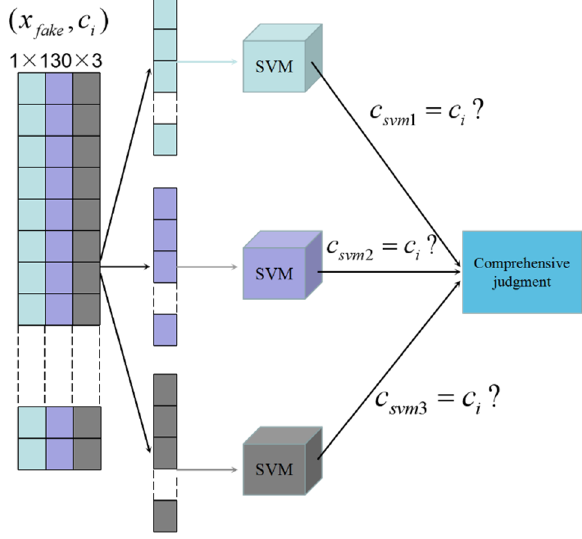
Figure 5. Integrated decision model.